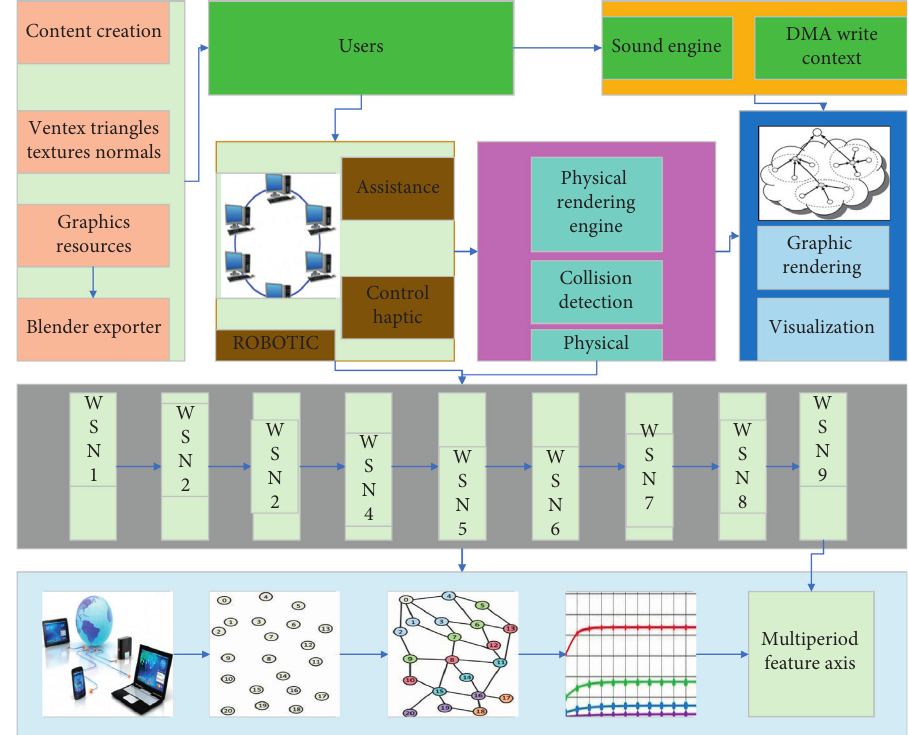
Figure 10: WSN control and MAC protocol performance in cyber-physical system.